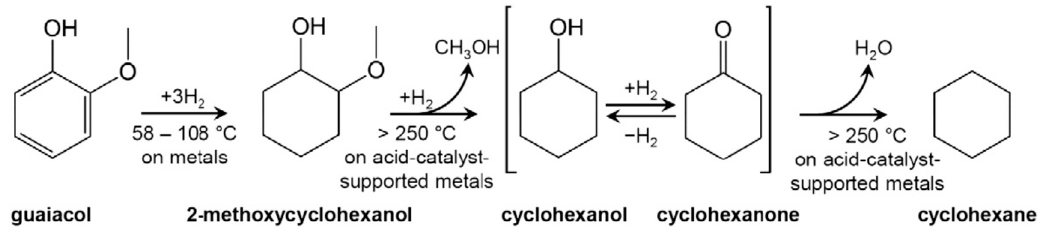
Figure 8. Guaiacol HDO over bifunctional metal supported acidic catalysts [45].